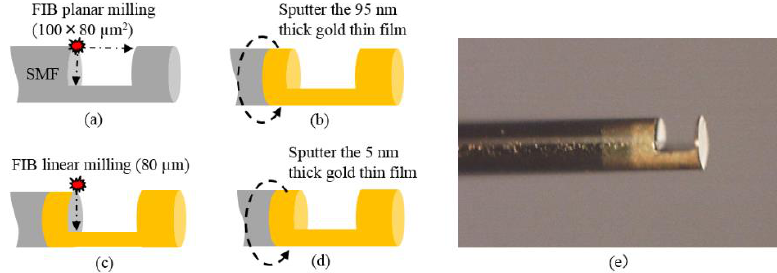
Figure 7. The schematic diagram of key procedures. ( a ) The micro-cavity is machined by FIB. ( b ) A 95 nm thick gold thin film is sputtered. ( c ) The gold film on the left of the micro-cavity is removed by FIB milling. ( d ) A 5 nm thick gold thin film is sputtered. ( e ) Image of the fabricated sensor head.